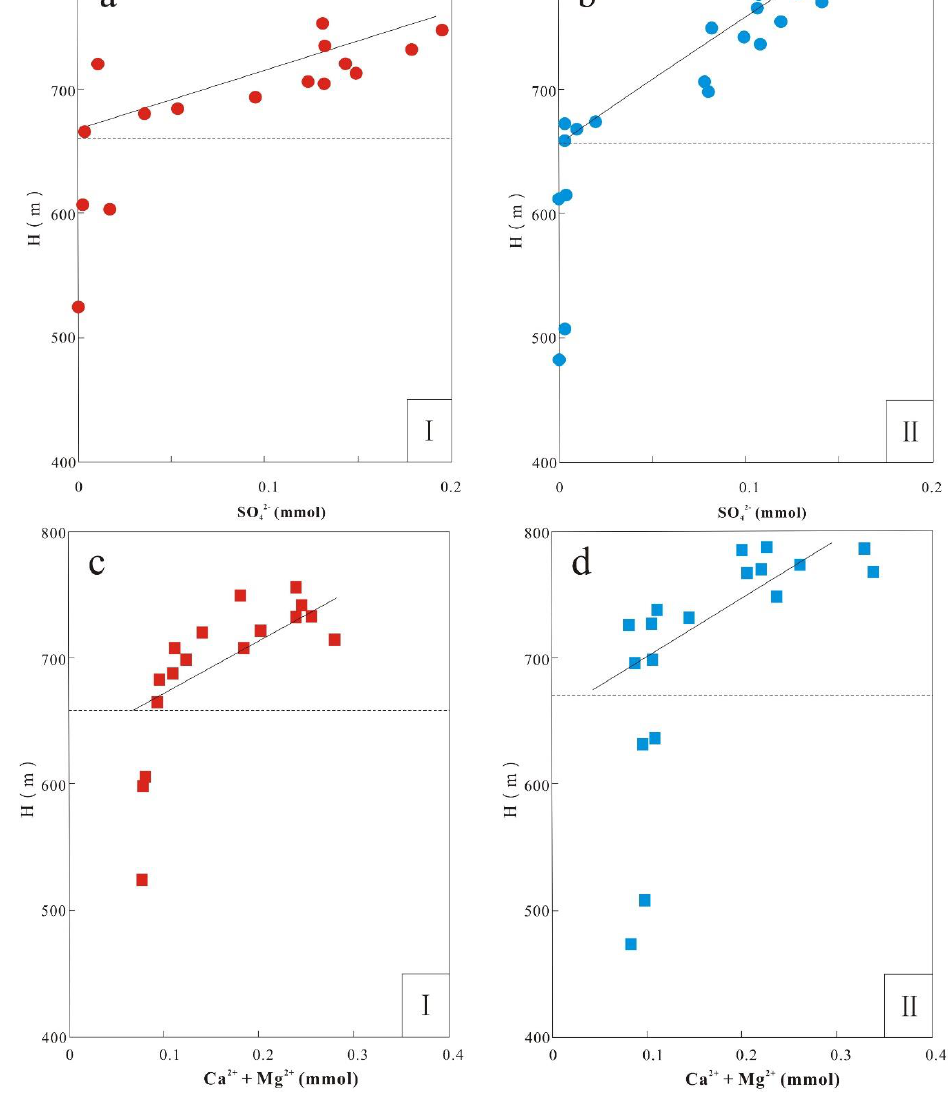
Figure 5. Concentration profiles for SO 42 − ( a , b ) and the sum of Ca 2+ and Mg 2+ ( c , d ), according to the hydraulic head (H) on the sampling lines I and II.